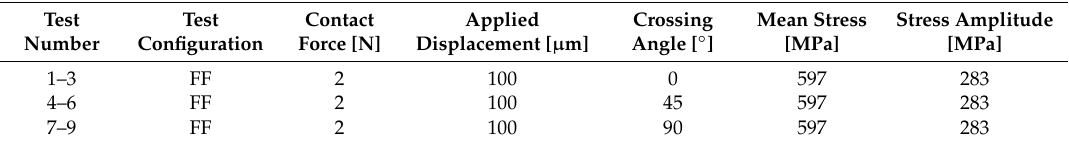
Table 1. Fretting fatigue (FF) test summary.